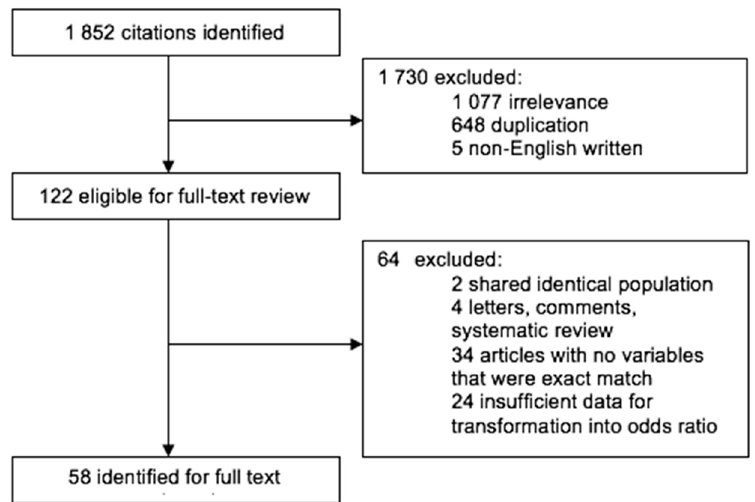
Figure 1. Flow diagram for identifying relevant studies. Note: OR: odds ratio; CI: confidence interval.